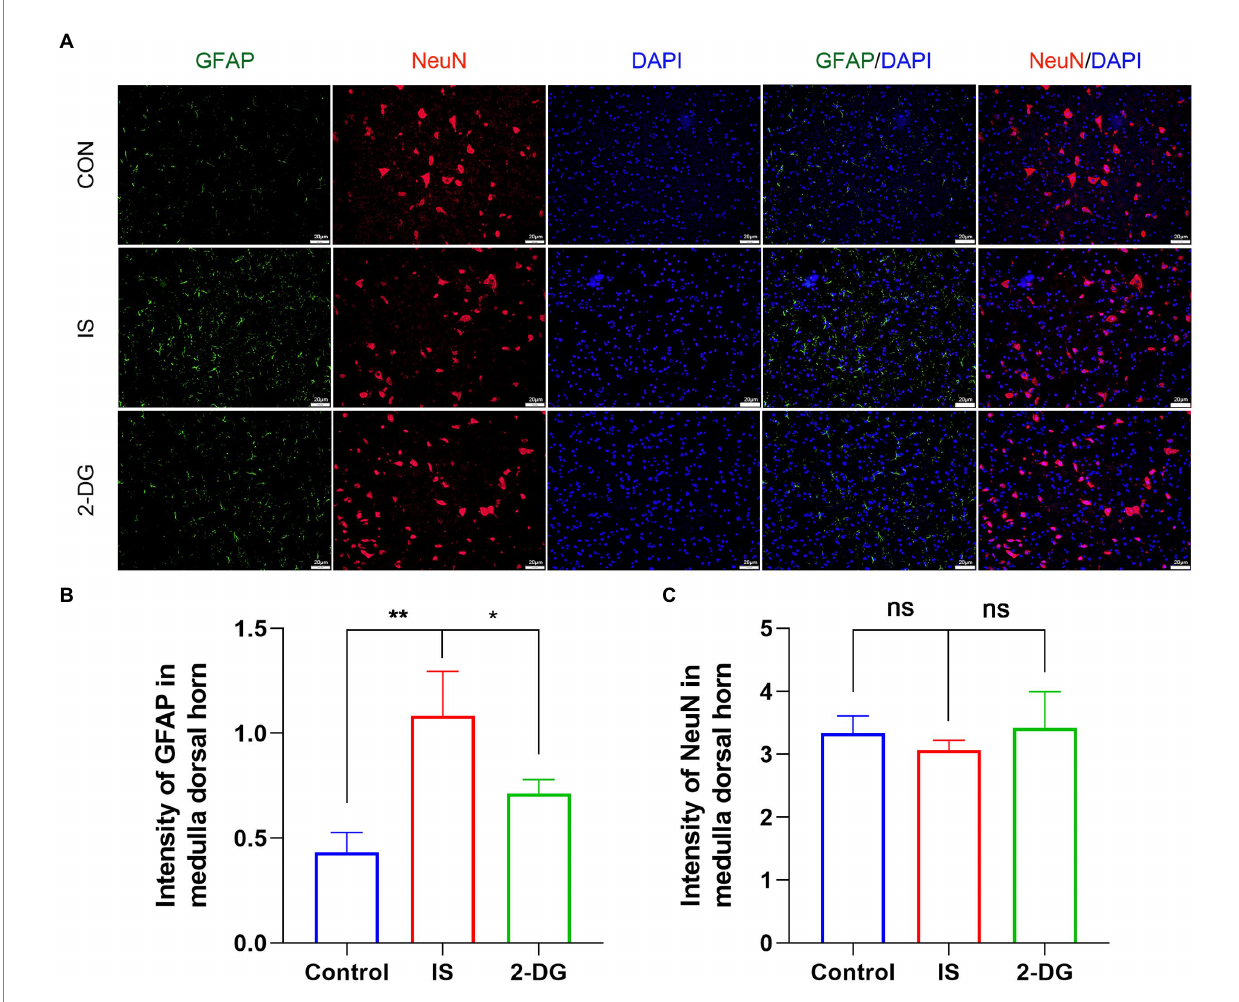
FIGURE 3 2-DG inhibited IS-induced astrocyte proliferation, but had no significant effect on neurons. (A) The immunoreactivity of GFAP and NeuN in medullary dorsal horn. (B) Quantification of GFAP immunofluorescence intensity in medulla dorsal horn. Data were expressed as mean ± SD ( n = 3 per group). * p < 0.05, ** p < 0.01. (C) Quantification of NeuN immunofluorescence intensity in medulla dorsal horn. Data were expressed as mean ± SD ( n = 3 per